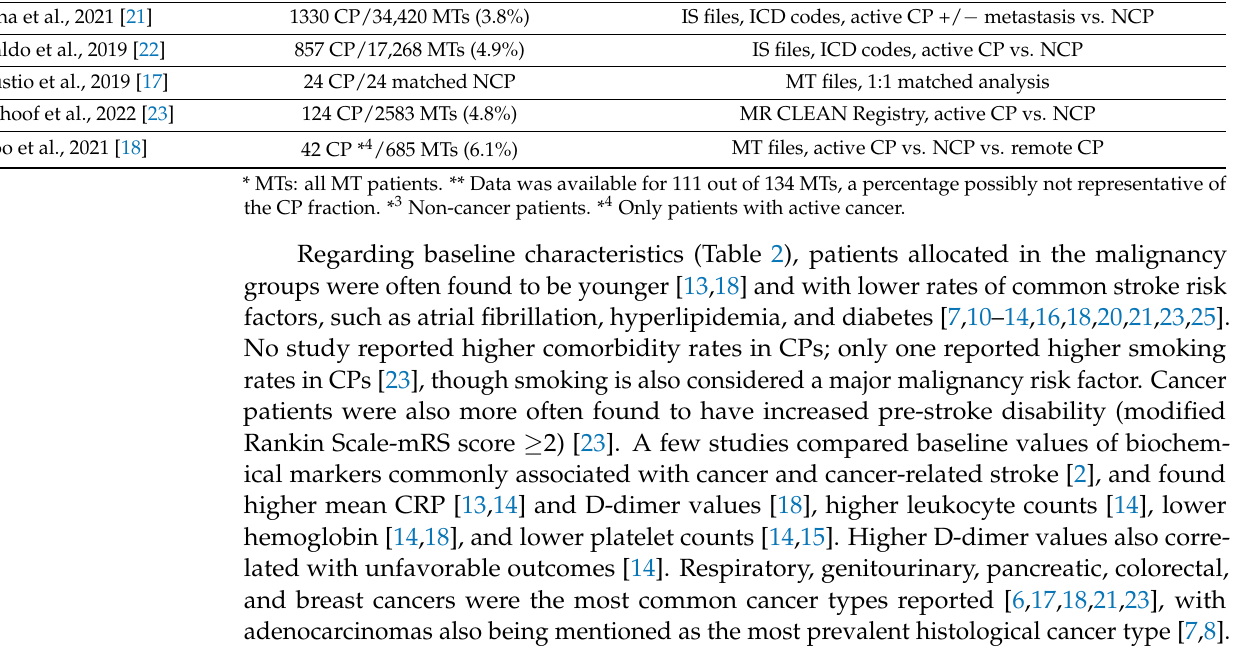
Table 2. Overview of baseline characteristics and cerebrovascular risk factors in cancer patients compared to non-cancer